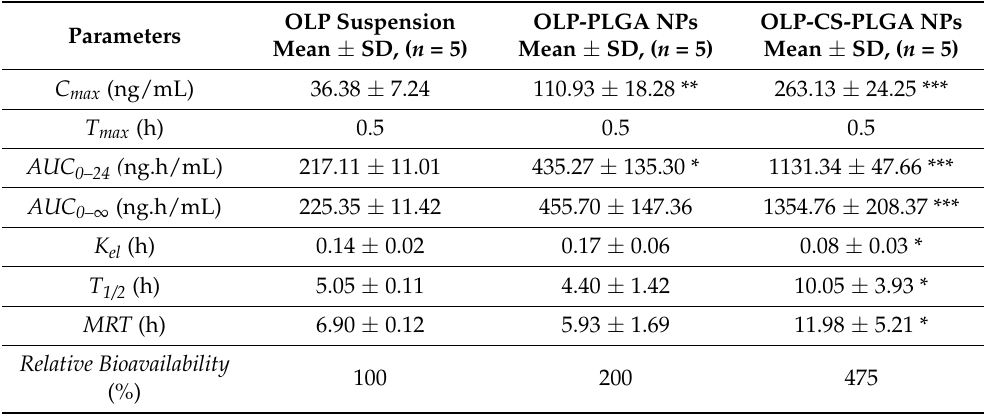
Table 3. Pharmacokinetic parameters after single oral dose of pure OLP suspension, OLP-PLGA NPs and OLP-CS-PLGA NPs administration (1 mg/kg in